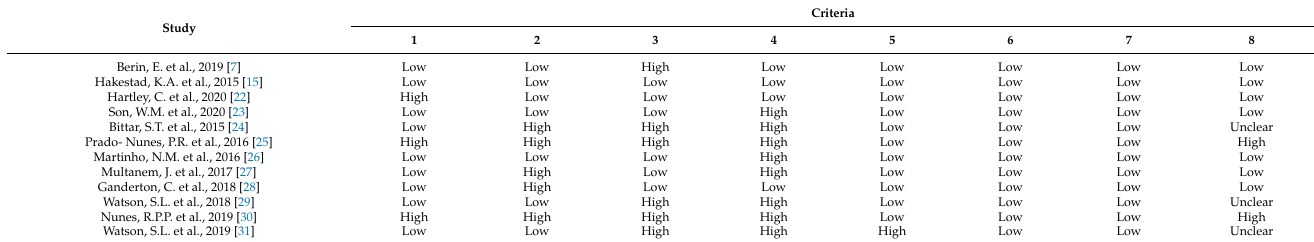
Table 3. Risk-of-bias summary: review authors’ judgements about each risk-of-bias item for each included